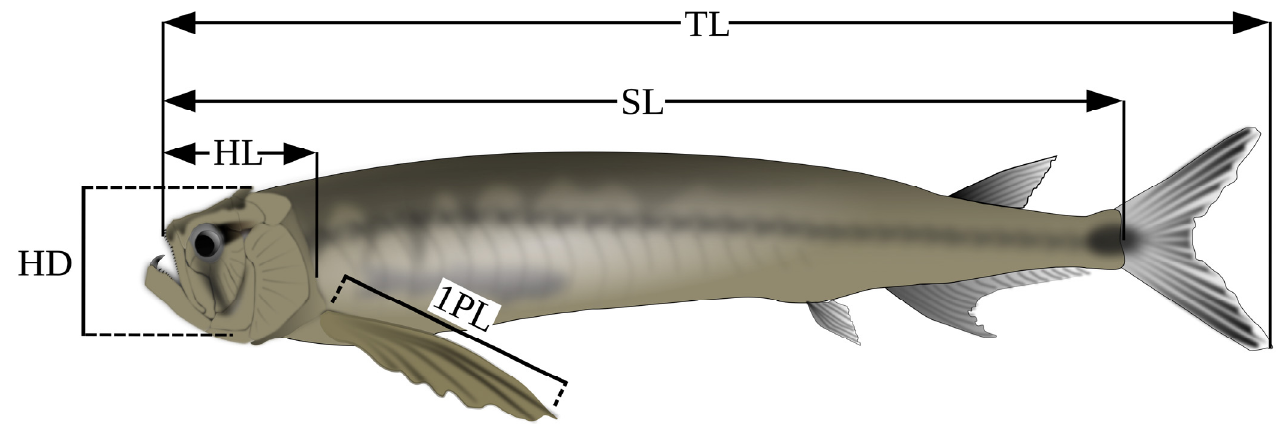
Figure 2. Diagram of anatomical measurements: HD : head depth; HL : head length; SL : standard length; TL : total length; 1PL : pectoral fin length.